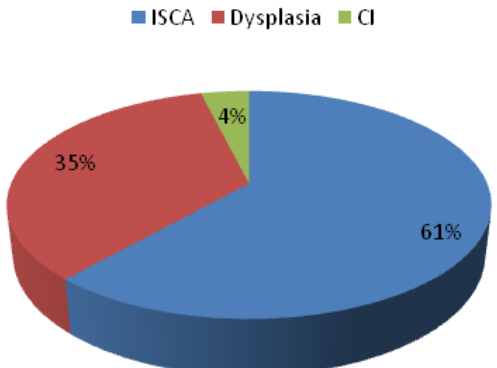
Figure 1. Distribution of OSSN by histological type. Key: ISCA-Invasive squamous cell carcinoma of conjunctiva, Dysplasia-(Mild, moderate or severe) and CI-Carcinoma in situ